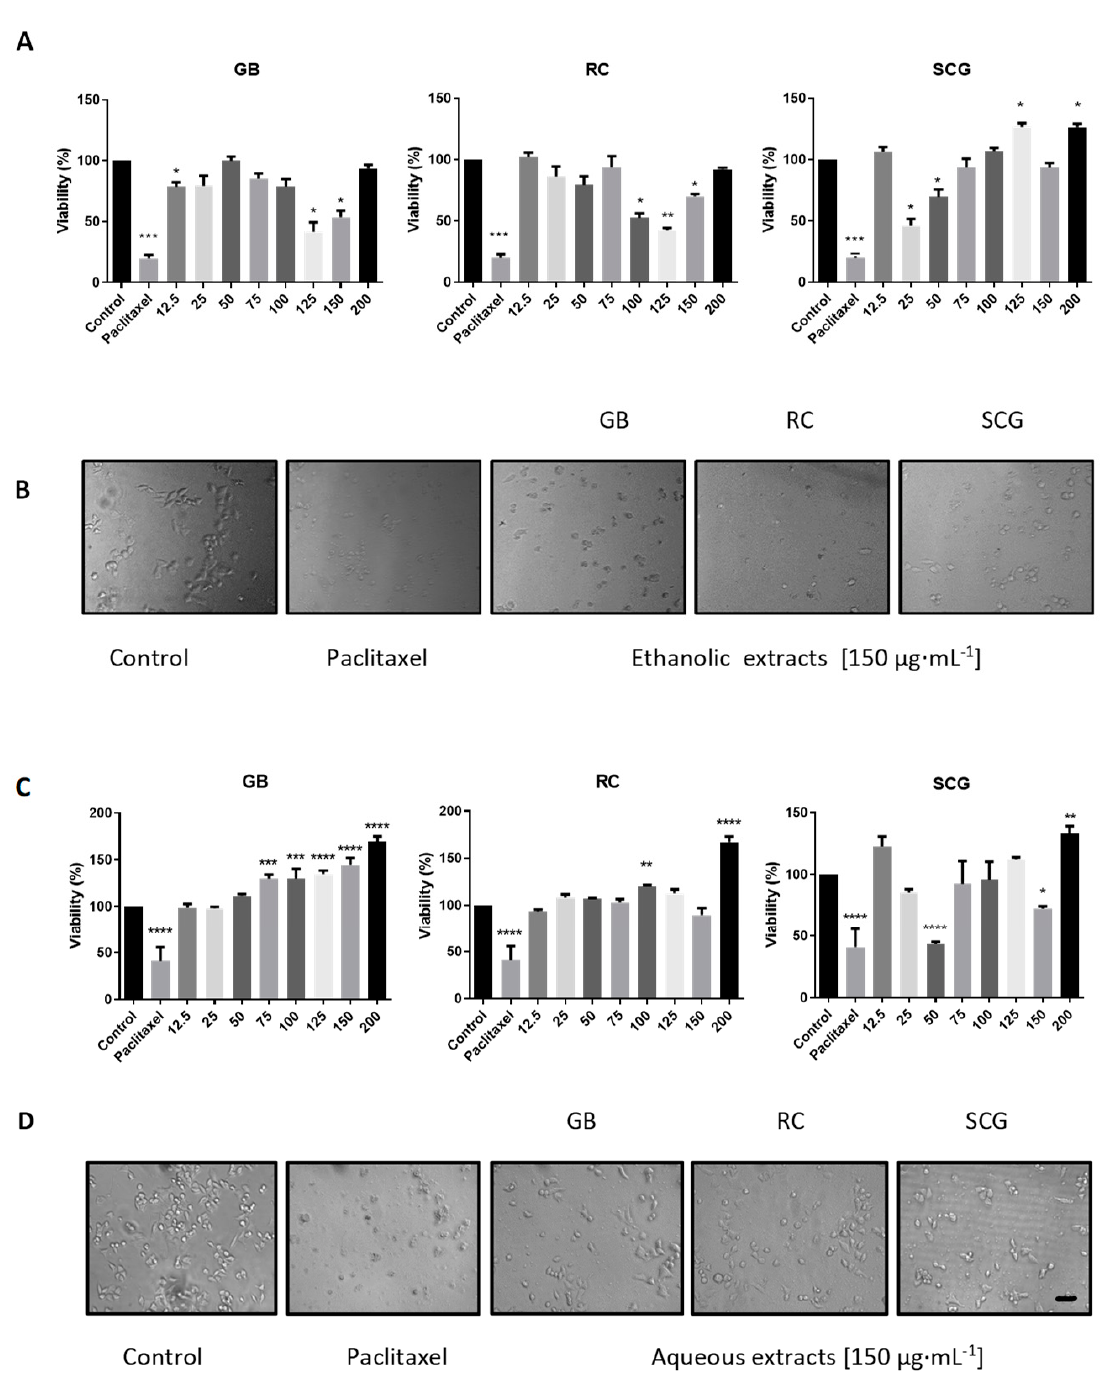
Figure 1. In vitro antiproliferative activity and morphological changes caused by ethanolic ( A , B ) and aqueous ( C , D ) extracts of GB, RC, and SCG in C33A cells. ( A ) Percentage of viability of C33A cells, treated with different concentrations of ethanolic extracts, to evaluate the effect on cell proliferation. Green bean, GB; roasted coffee, RC; spent coffee grounds, SCG; and paclitaxel as positive control (120 nM) during 24 h. ( B ) Morphological changes caused by coffee ethanolic extracts evaluated at 150 µ g · mL − 1 . Reductions in the number of cells compared with control and intracellular inclusions, such as apoptotic bodies, can be observed. ( C ) Percentage of viability of C33A cells treated with different concentrations of aqueous extracts, to evaluate the effect of the extracts on cell proliferation. ( D ) Morphological changes caused by aqueous coffee extracts evaluated at 150 µ g · mL − 1 . Calibration bar, 50 µ m. Dunnett: ****, p < 0.0001; ***, p < 0.001; **, p < 0.01; and *, p < 0.05. In A549 cells, the ethanolic extract from SCG diminished up to 35.5% cell prolifera ‐ tion at 12.5 μ g ∙ mL − 1 , while the aqueous extract from SCG and RC only reduced cell viabil ‐ ity at the highest concentration evaluated (200 μ g ∙ mL − 1 ); see Figure 2A–C.